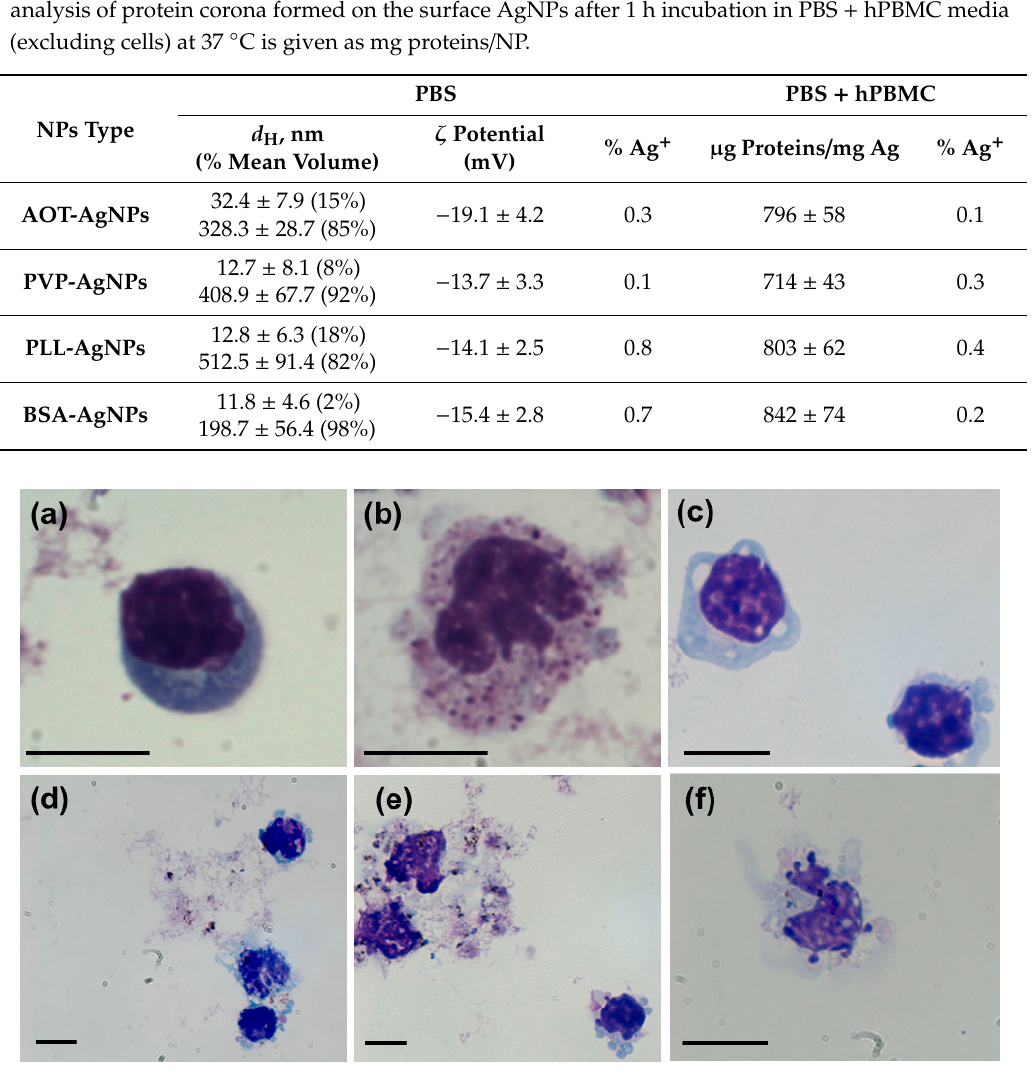
Figure 2. Light microscopy images of control, untreated ( a ) lymphocyte and ( b ) monocyte. Treatment of AgNPs coated with AOT, PVP, PLL and BSA induced morphological alterations of human peripheral blood mononuclear cells (hPBMC). ( c ) Vacuolization and apoptotic bodies in lymphocytes treated with AOT-AgNPs. ( d ) Alterations in lymphocytes and monocytes treated with PVP-AgNPs. ( e ) Necrotic cells (in the upper left corner) and apoptotic bodies in lymphocytes (down right corner) after treatment with PLL-AgNPs. ( f ) Intracytoplasmic vacuoles, enlarged multi-lobed nuclei and ruffled surface of monocyte treated with BSA-AgNPs. Scale bars are in 10 µm. Flow cytometry experiments using FITC Annexin V Apoptosis Detection Kit I allowed us to evaluate ability of different AgNPs to induce apoptosis and cell death in hPBMC. All four types of tested AgNPs induced cell death and apoptosis in a dose- and time-response (Figure 3). Significant